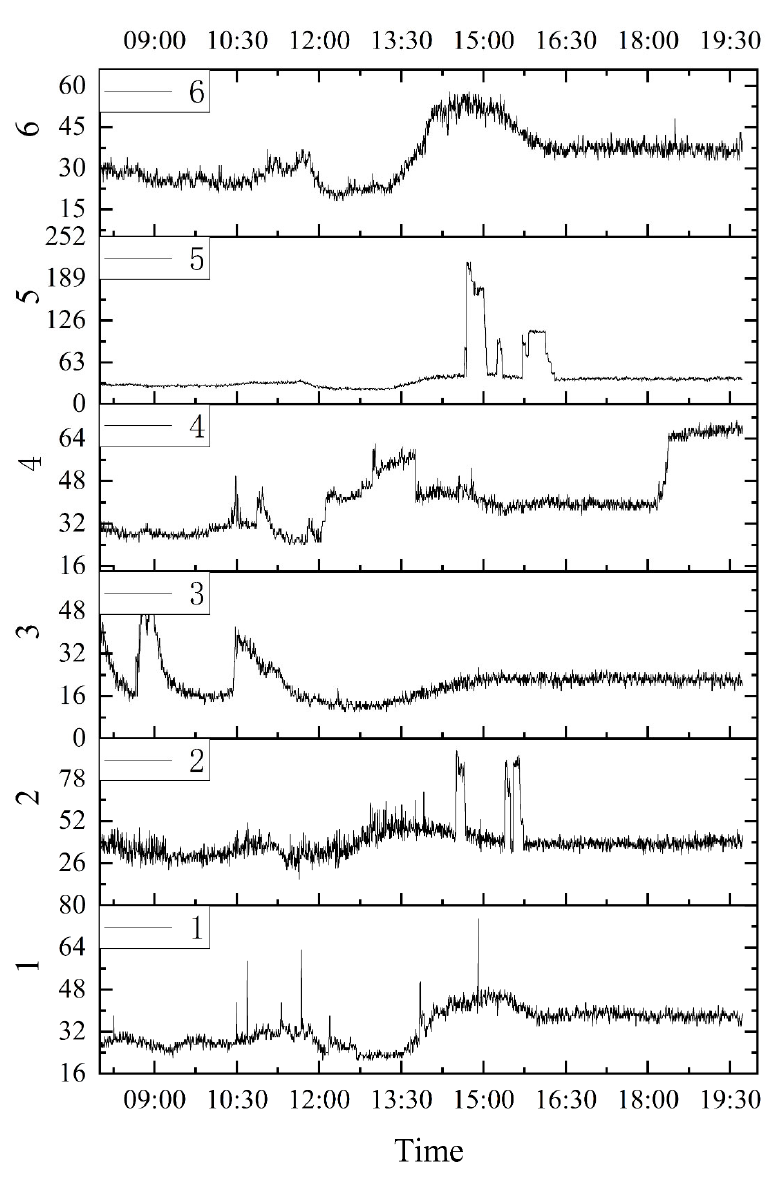
Figure 4. Variation of PM 2.5 concentration at different monitoring points in the diesel generator plant.